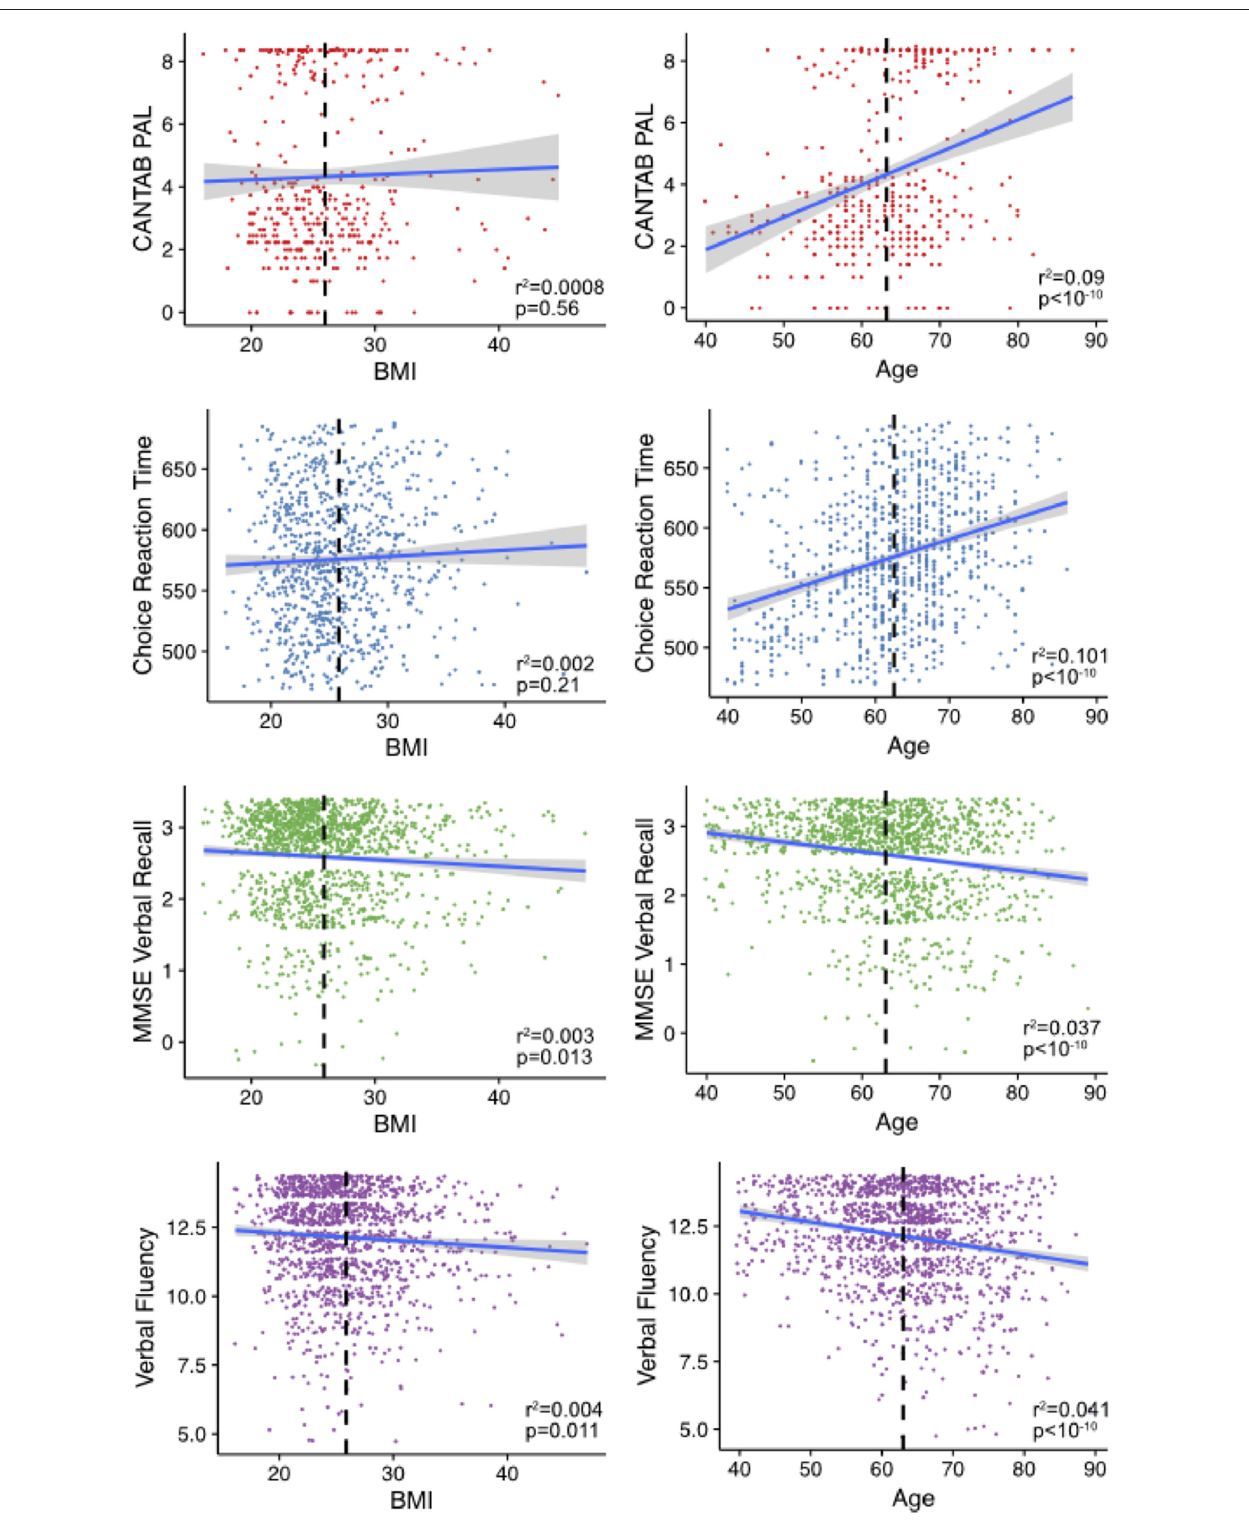
FIGURE 1 | Age and body mass index (BMI) associations with cognitive measures. Shown are the age and BMIs plotted against the relative cognitive score for individuals in the study. Mean age and BMI in each of the sub-sets is shown in the dashed black line. The line is fitted using the geom_smooth command in ggplot2 within R. The variables verbal fluency and Mini-Mental State Examination (MMSE) recall are plotted with jitter to disperse points within groups.